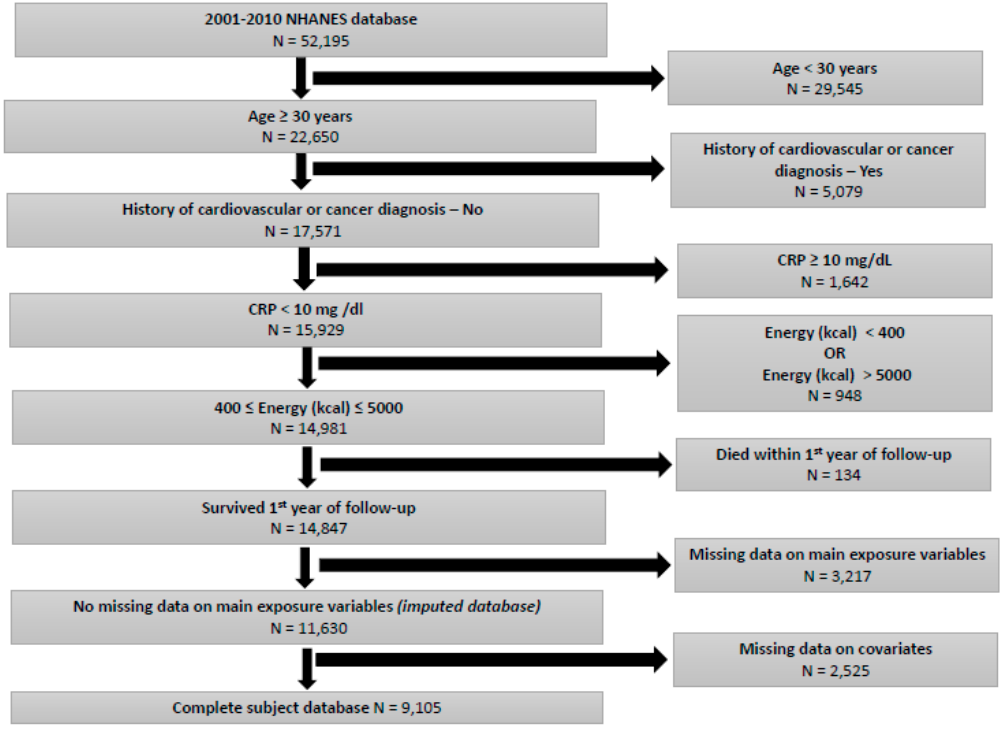
Figure 1. Study Figure 1. Study Flowchart.